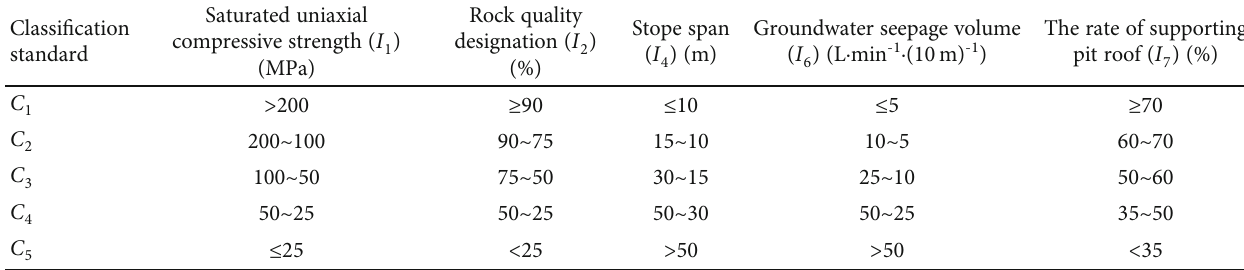
Table 1: Classi fi cation criterion of quantitative indices.